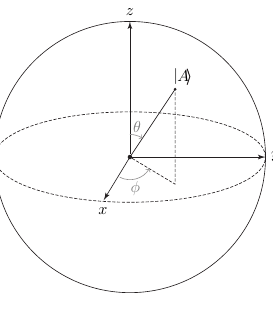
Figure 13: Quantum state | A 〉 on the Bloch